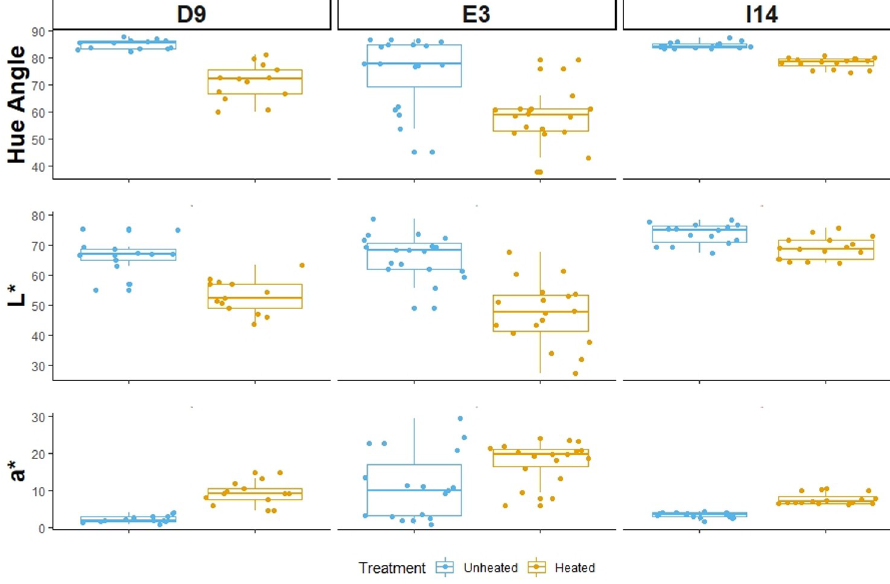
Fig 3. CIE L � a � b � variables across level of treatment by source. Boxplots comparing the distributions of three colorimetry variables (hue-angle, L � , a � ) between unheated and heat-treated silcrete specimens across all three sources (D9, E3, I14). Chroma and b � were excluded from this figure because they did not show significant differences between level of treatment.